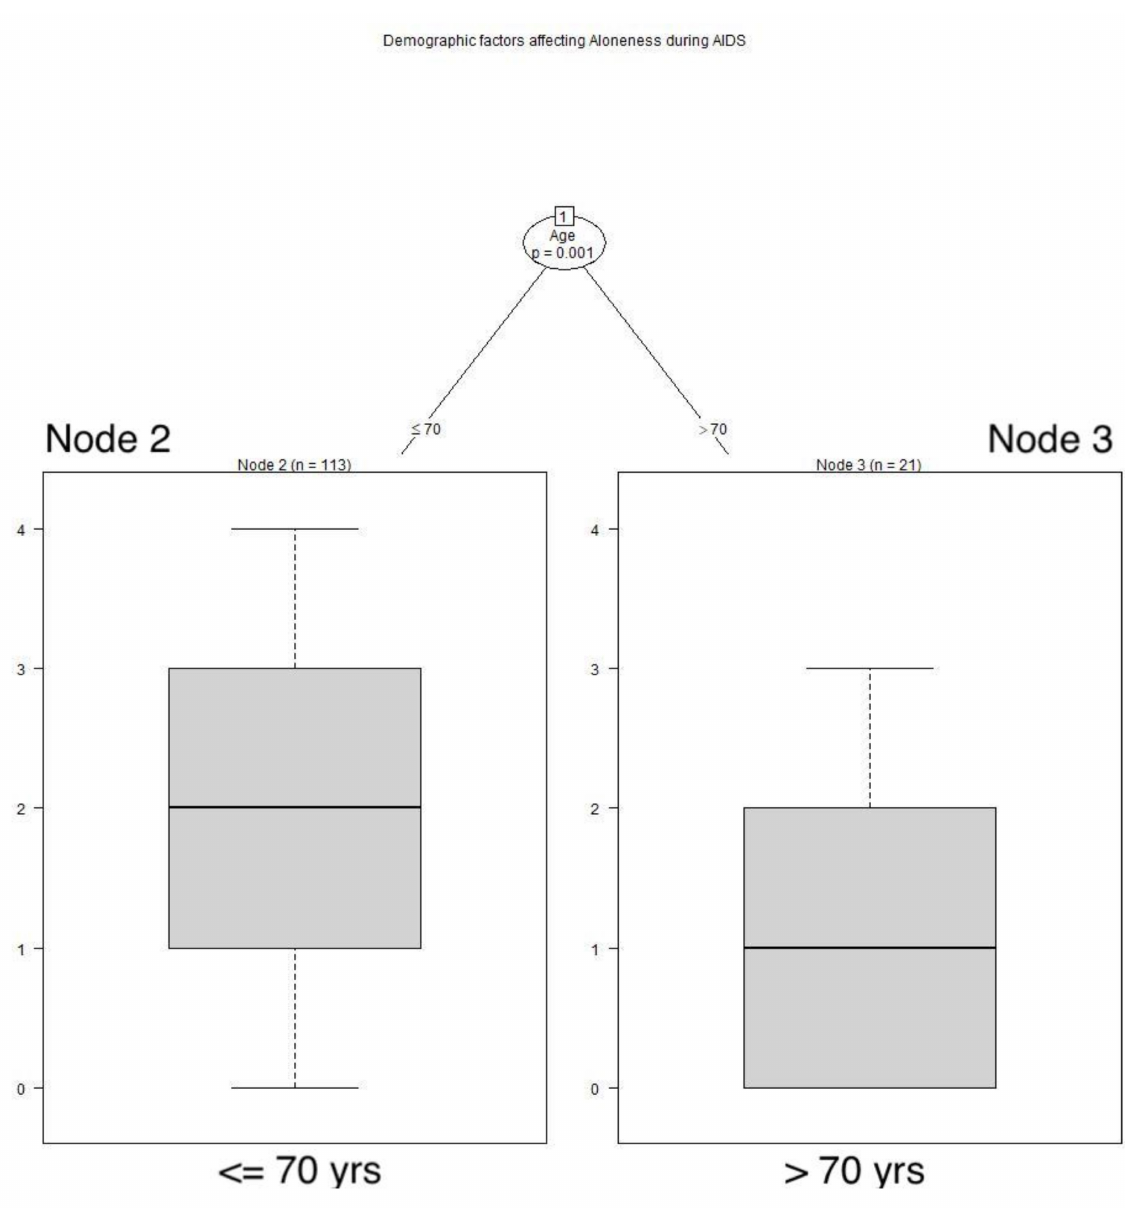
Figure 2. Demographic factors affecting aloneness during AIDS. Respondents older than 70 years of age felt alone significantly less often during the AIDS pandemic than younger respondents: Node 2: x − = 1.965, SD 1.1489; Node 3: x − = 1.048, SD